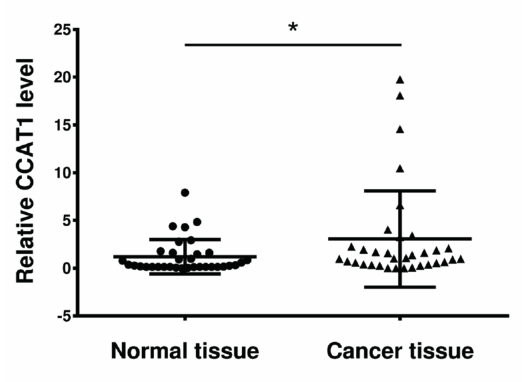
Figure 1 - The gene expression level of CCAT1 in human bladder tumor tissues and paratumor tissues (n = 34).